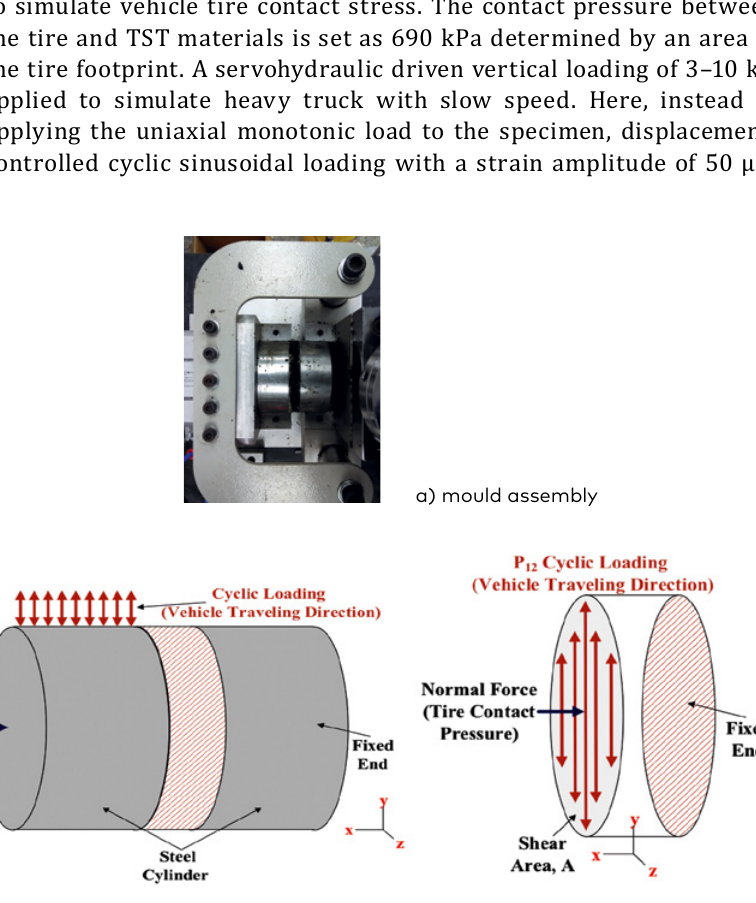
Figure 3. Dynamic direct shear test